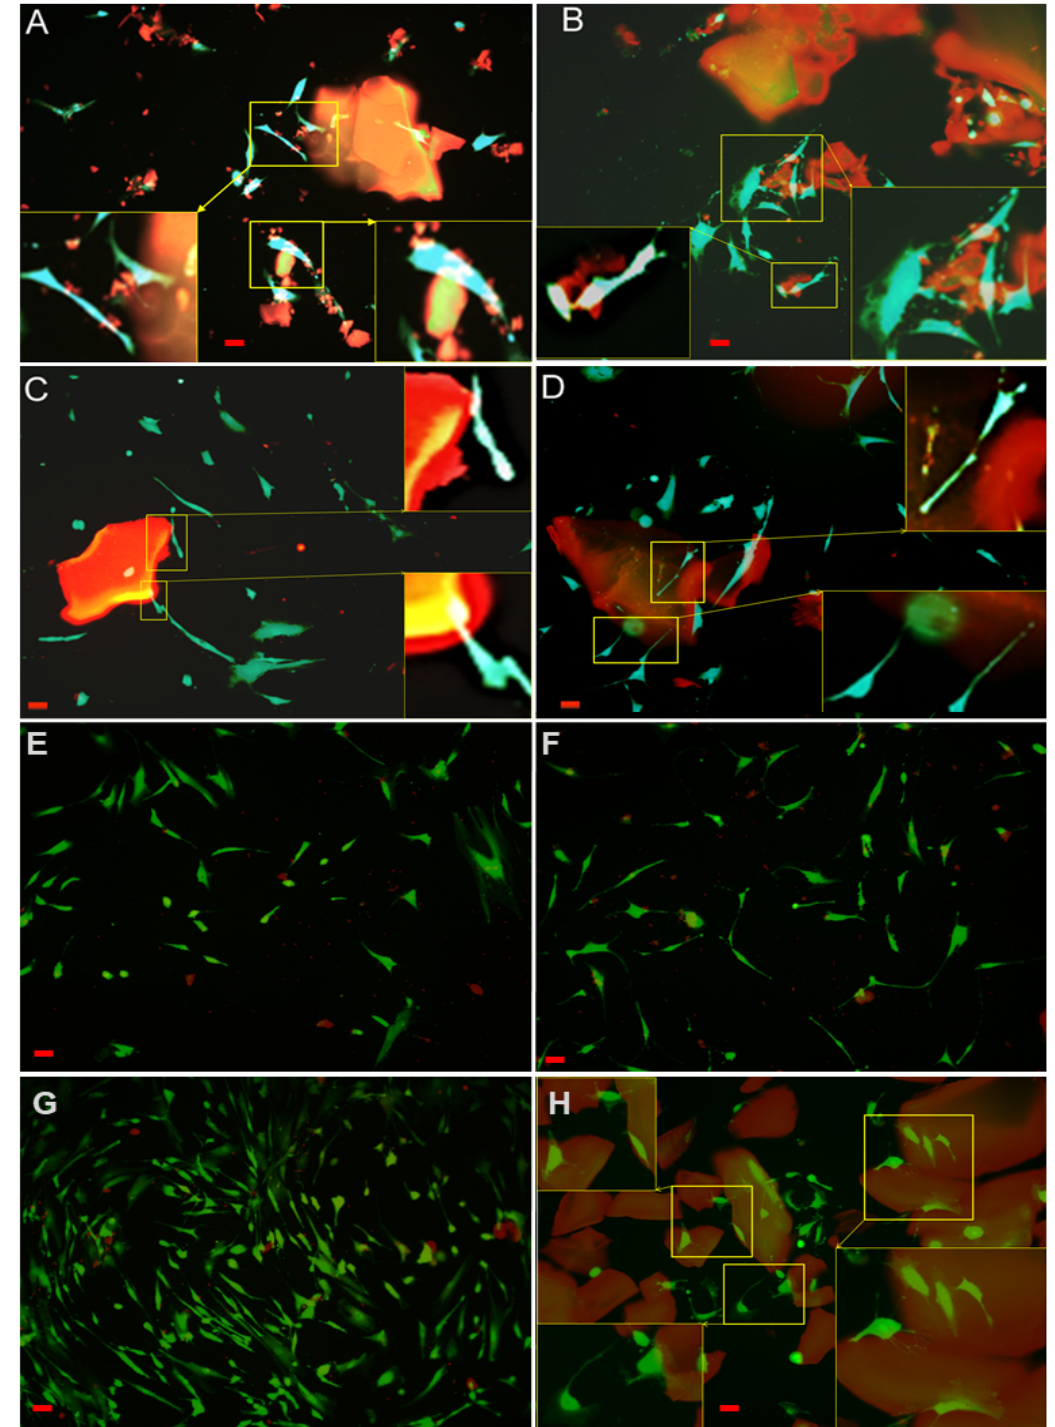
Figure 8. Live/Dead staining of osteoblasts growing on ( A ): CS4G0 after 48 h in culture; ( B ): CS4G0 after 72 h in culture; ( C ): CS7G2 after 48 H in culture; ( D ): CS7G2 after 72 h in culture; ( E ): Control cells grown on glass after 48 h in culture; ( F ): Control cells grown on glass after 72 h in culture. In ( G ): Control cells grown on glass after 1 week in culture; ( H ): osteoblasts grown on CS10G4 after 1 week in culture. Live cells appear green; nuclei of dead cells fluoresce red once examined with fluorescence microscope (10× objective lens). Scale bar represents 50 µm. Squares select and amplify filopodial emissions pointing to material surface.